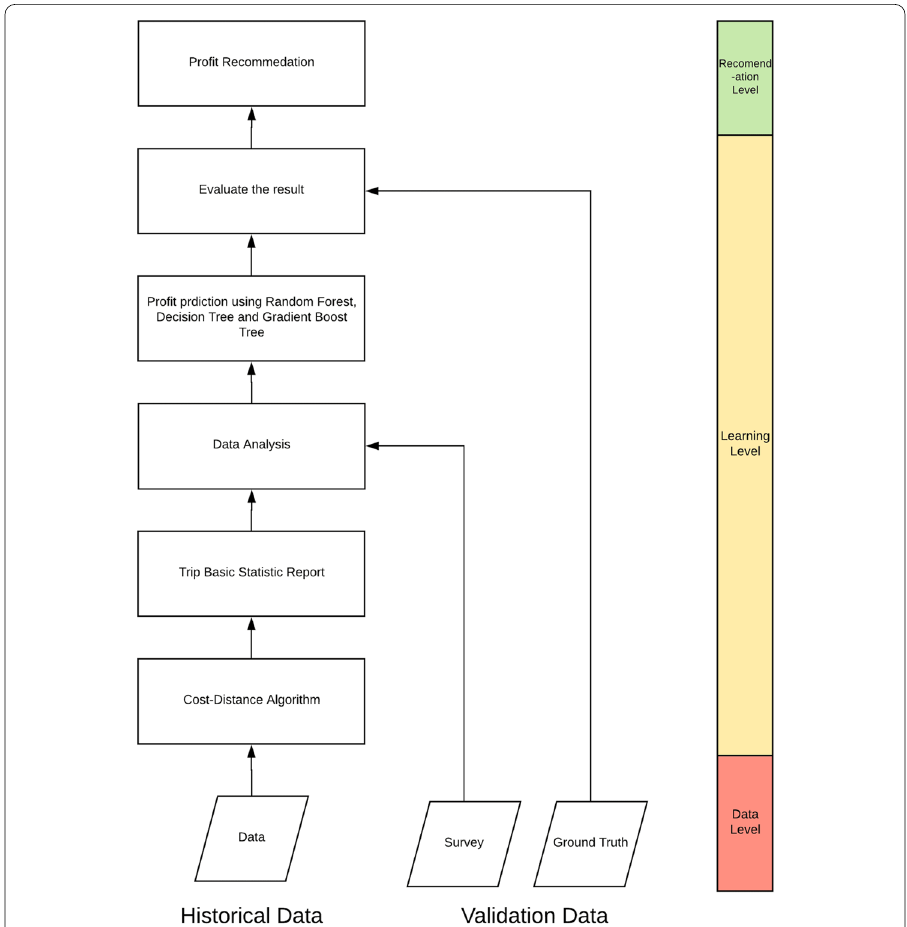
Fig. 2 Data-driven framework for analyze taxi probe